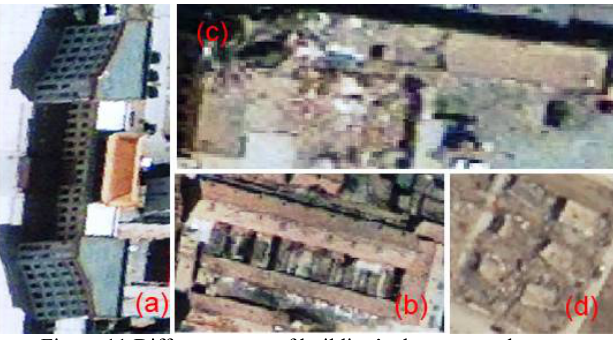
Figure 11 Different types of building’s damage grades